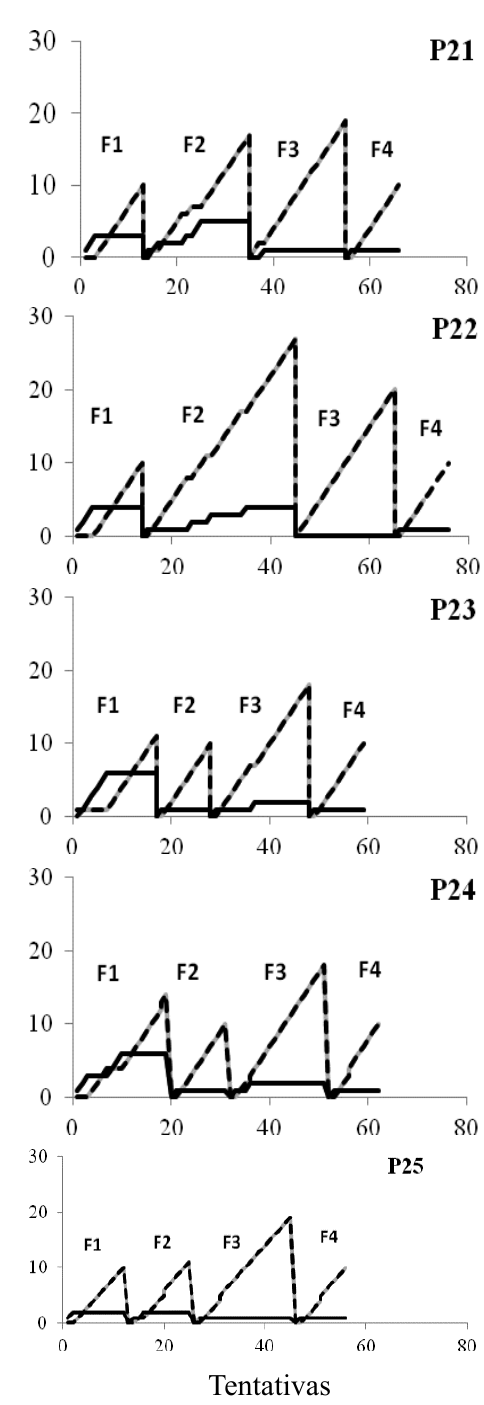
Figura 2. Frequência acumulada de respostas de seguimento de instrução (linha sólida) e de não seguimento de instrução (linha tracejada), para cada participante da Condição II, durante cada fase (F) experimental. Quebras na curva acumulada indicam mu- danças de fase. Nas Fases 1, 2 e 4 eram apresentadas